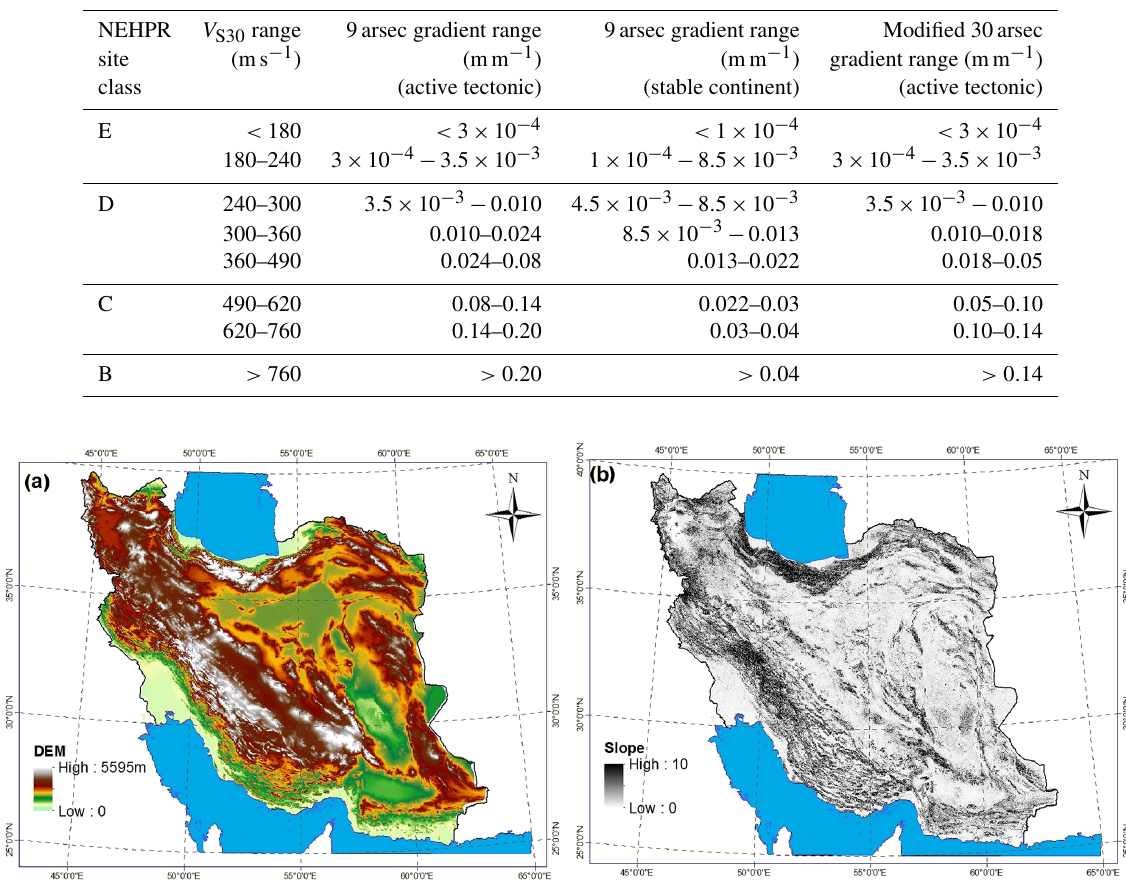
Table 1. Correlations between topographic gradient and VS30 using the NED 9c digital elevation models for the National Earthquake Hazard Reduction Program (NEHRP) site classes (Allen and Wald, 2009).